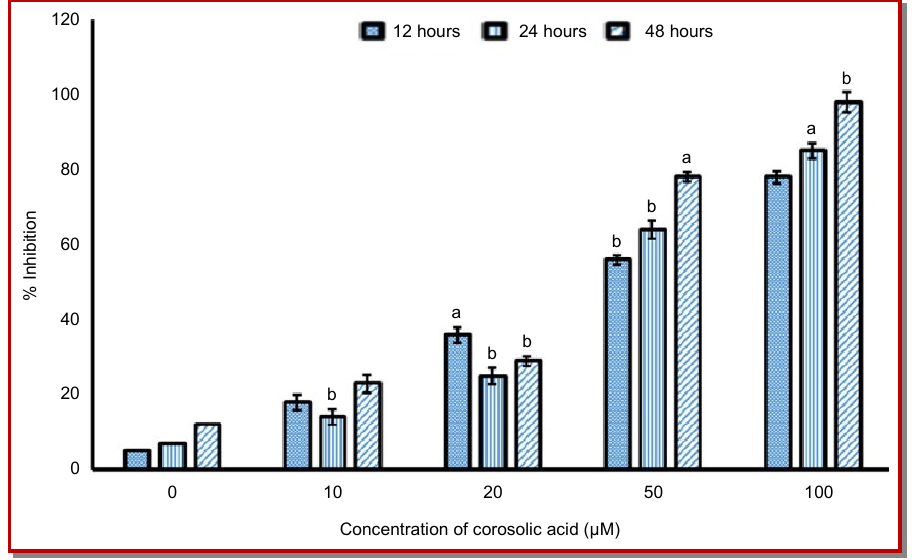
Figure 2: Growth inhibitory effect of corosolic acid in human cer vical cancer cells (CaSki) at increasing doses. Data are shown as the mean ± SD of three independent experiments. a p<0.05, b p<0.01, vs 0 µM (control). MTT assay was used to evaluate the cell cytotoxicity of this